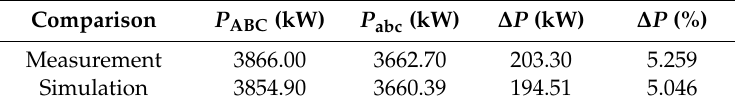
Table 4. Three-phase values of active power and active power